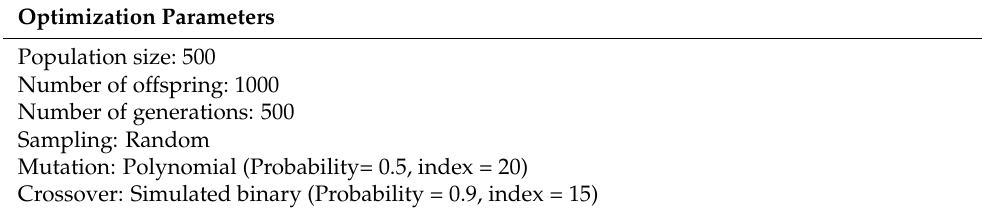
Table 10. NSGA-II operating